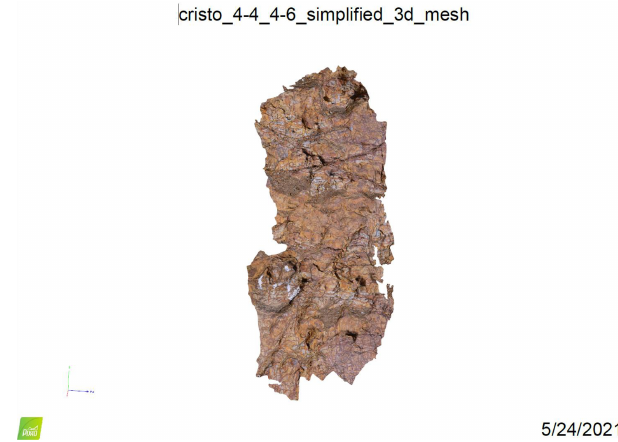
Figure 8. This figure is a 2-D image of the 3-D PDF of Cristo Rey sections 4–5 and 4–6 included in the Supplement to this